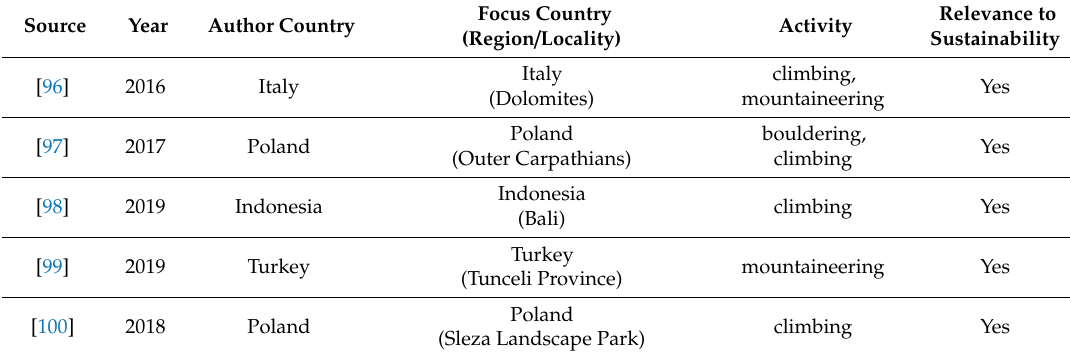
Table 1. Basic information on the reviewed sources (only papers dealing simultaneously with geoheritage and